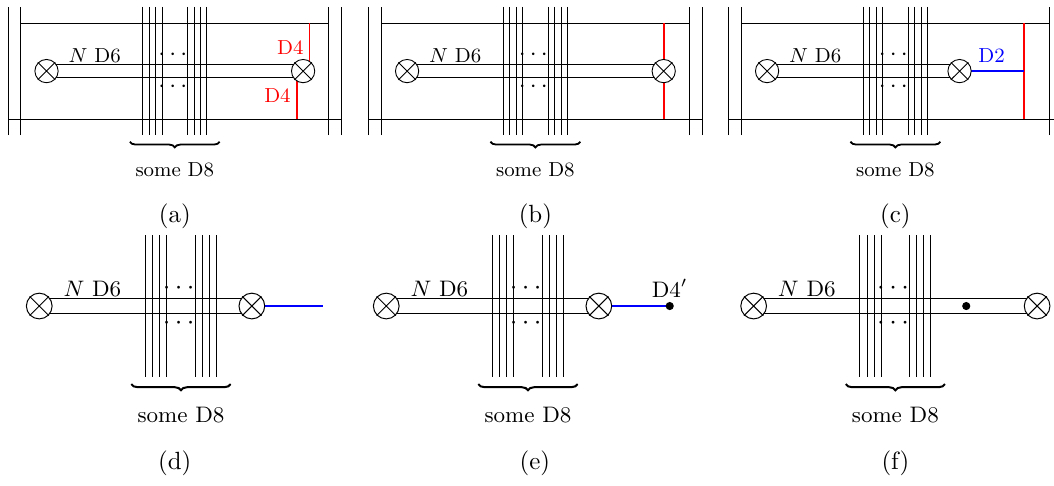
Figure 3. Cartoon for the realization of a codimension 4 defect via tuning of two codimension 2 defects. For simplicity, the O6-plane is omitted in this discussion. In (a), two codimension 2 defects are introduced via defect Higgsing that leave behind D4-branes. In (b), the defect D4-branes are tuned such that they can reconnect and form a single brane. The tuning is such that the resulting D4-brane can move along the D6-branes in x 6 direction, but leaves behind a D2-brane extended in x 0 , 1 , 6 as in (c). In (d), the D4 and the D6-branes have been moved off to infinite. In (e), the semi-infinite D2 is terminated on a D 4 0 -brane, which is extended along x 0 , 1 , 7 , 8 , 9 . In (f), the D 4 0 is moved through the NS5 upon which the D2 is